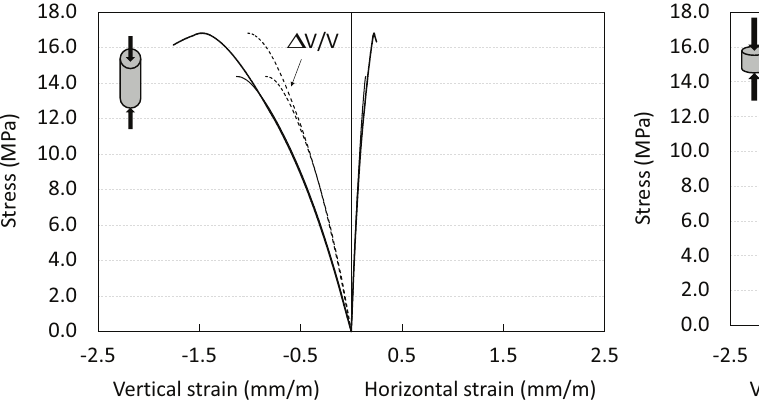
Volumetric strain for mortar ii (stronger mortar)